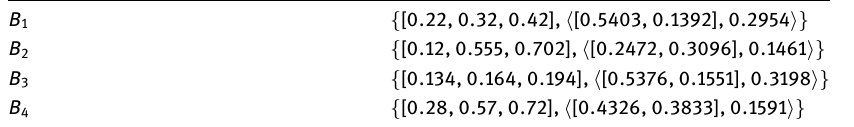
Table 14: Aggregating Matrix on Triangular Cubic Fuzzy Number.